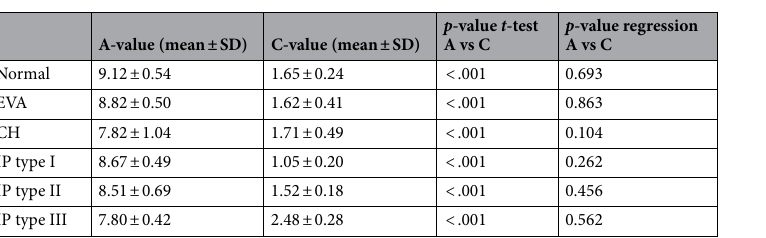
Table 2. Statistical significance of A and C values of different anatomical types of